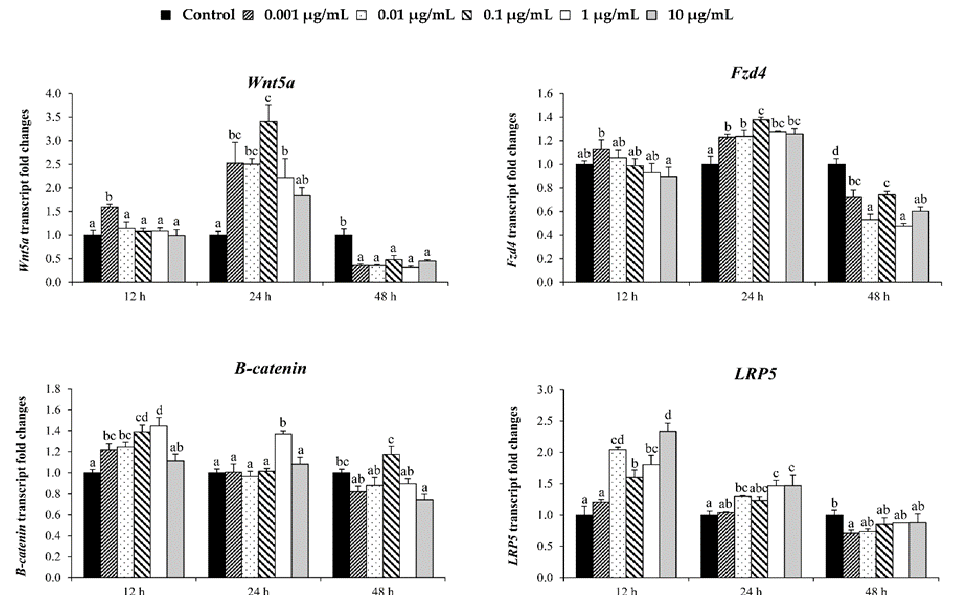
Figure 7. Analysis of mRNA level expressions of Wnt / β -catenin signaling pathway genes LRP5 , β -catenin , Wnt5a , and fzd4 by quantitative real-time PCR. MC3T3-E1 cells were treated with Ps -GOS in various concentrations for 24, 48, and 72 h. The data were obtained from three independent experiments in four replicates as mean ± SEM. The data in columns with di ff erent letters in each group were significantly di ff erent at p < 0.05.